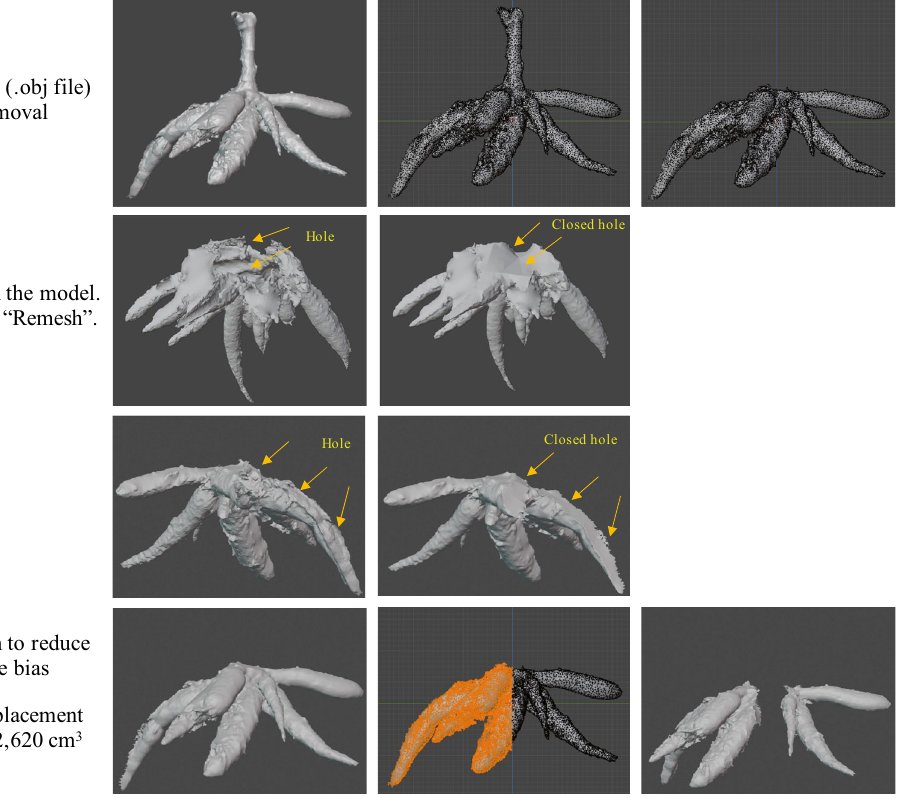
Figure 5. 3D object manipulations for root crown measurements in Blender environment (Blender 2.90.1: http:// www. blend er. org). ( a ) The stem section is manually removed from the root crown. ( b ) Holes in the object surface are closed using a “Remesh” tool in Blender. Two representatives of hole closing are presented. ( c ) A 3D crown is manually split in half to reduce volume bias. Crown volumes obtained from water replacement, intact crown and split crown are indicated.